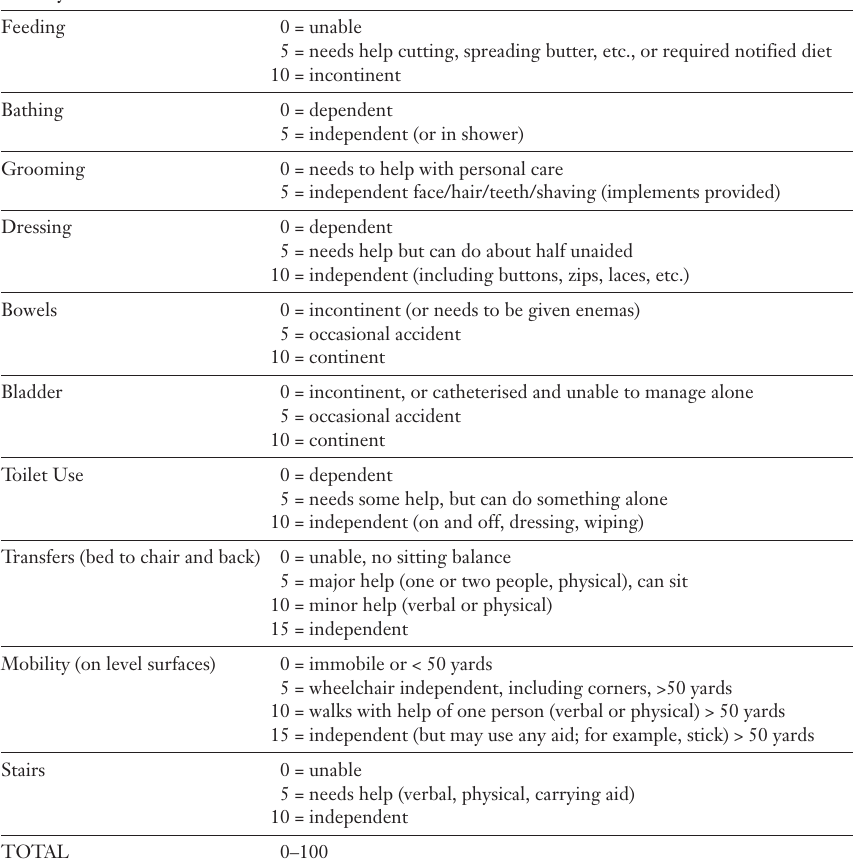
Modified Rankin Scale [15,